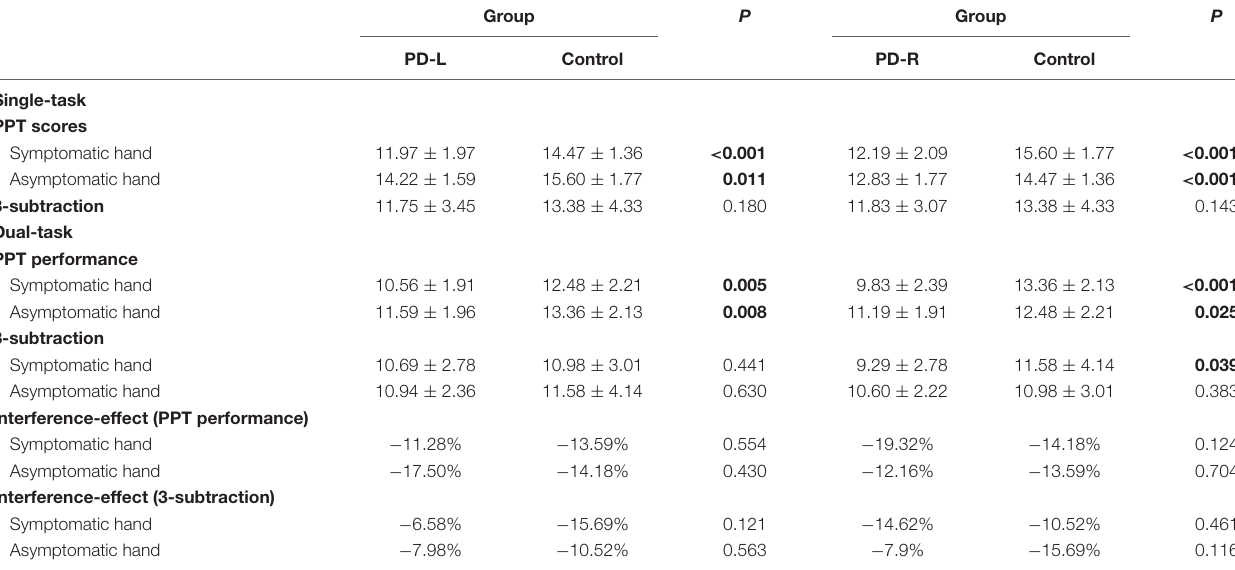
TABLE 2 | Uni- and dual-tasks of subtract 3 and Purdue Pegboard performance in the hemiparkinsonia patients and normal controls. Group P Group P PD-L Control PD-R